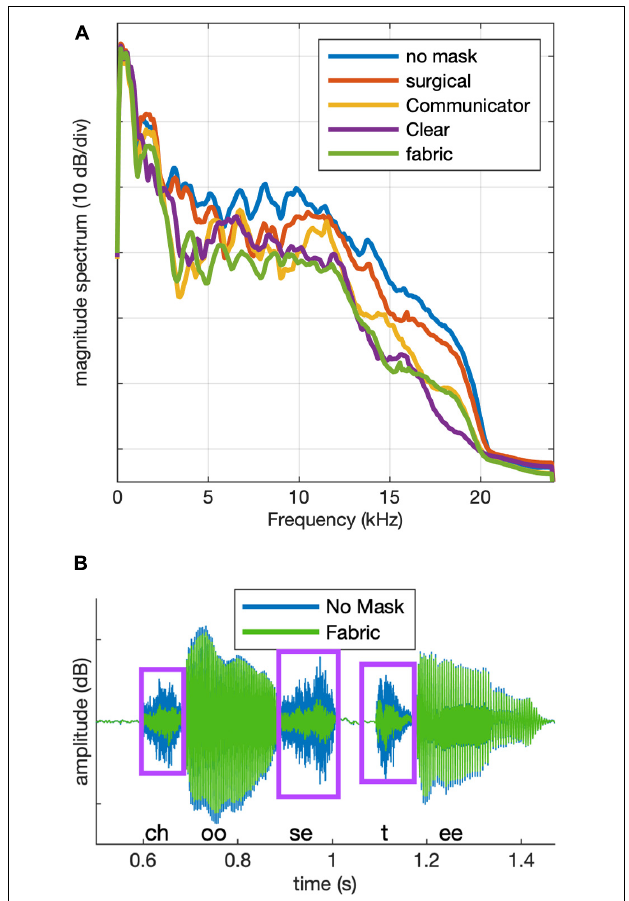
FIGURE 2 | (A) Long-term magnitude spectra for stimuli in each of the five conditions. (B) Example target stimulus waveform after filtering for the no mask (blue) and fabric mask (green) conditions. Boxes indicate consonant